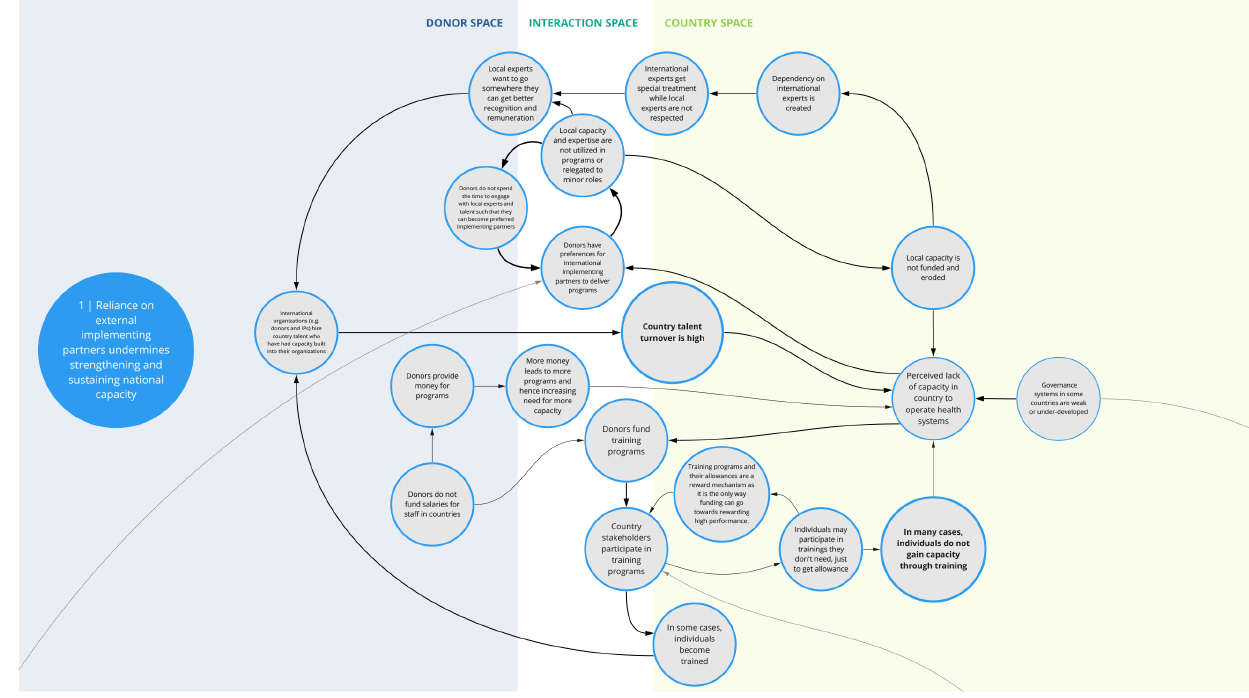
Figure 2. Syndrome 1: Reliance on external implementing partners undermines strengthening and sustaining national